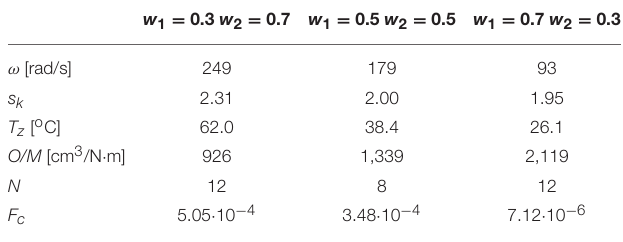
TABLE 5 | Calculation results for U = 2 kV, 30 ≤ ω ≤ 250 rad/s, 5 ≤ n ≤ 13, w = 30%.